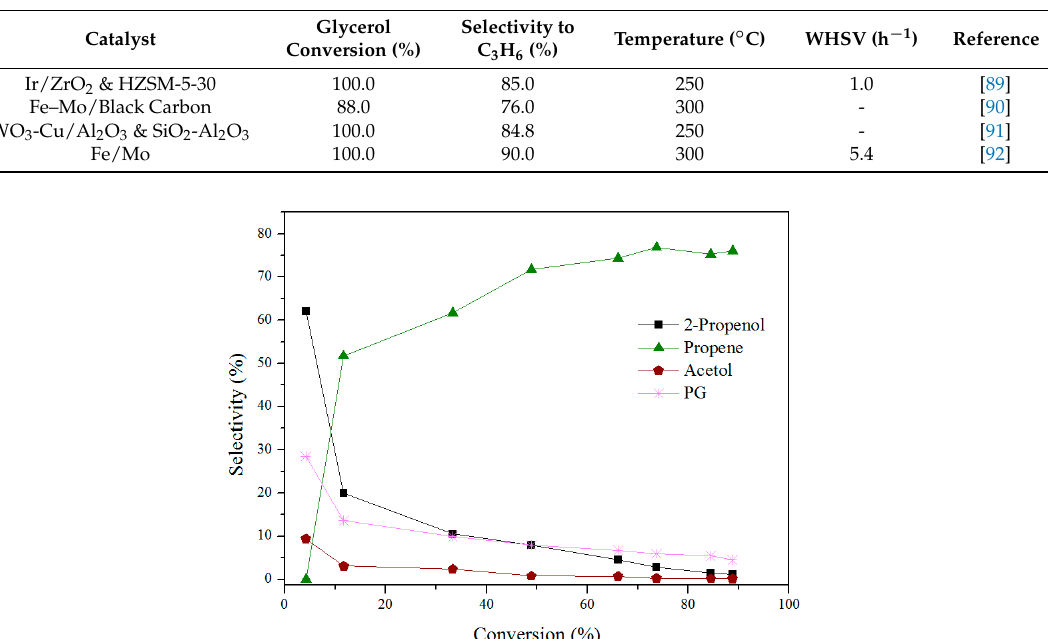
Table 3. Selected catalysts for one-step glycerol conversion into C 3 H 6 .